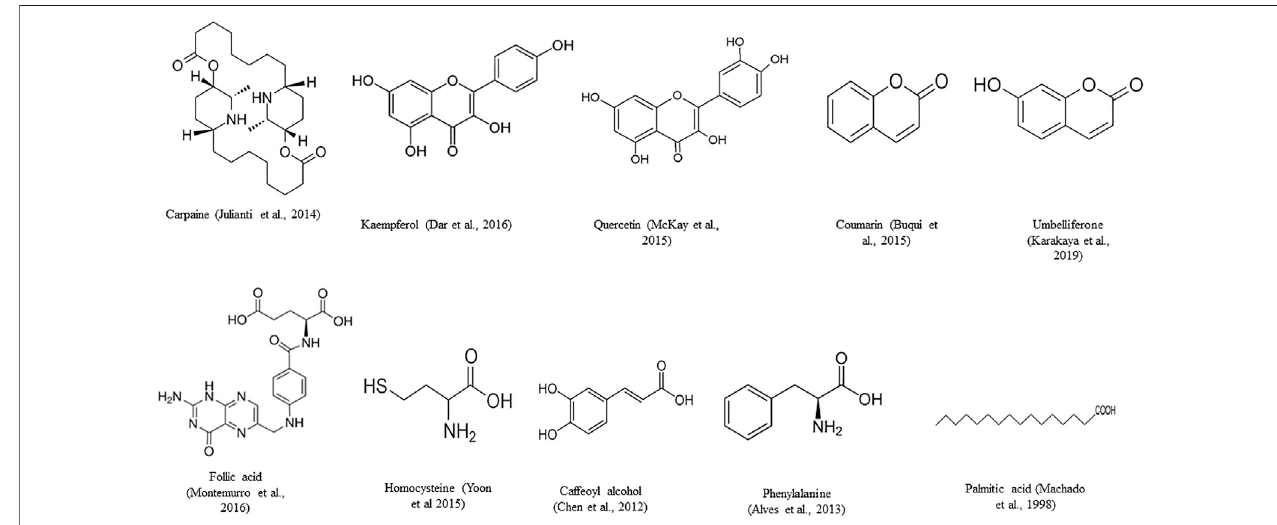
FIGURE 6 | Phytocompounds isolated from Carica papaya L.